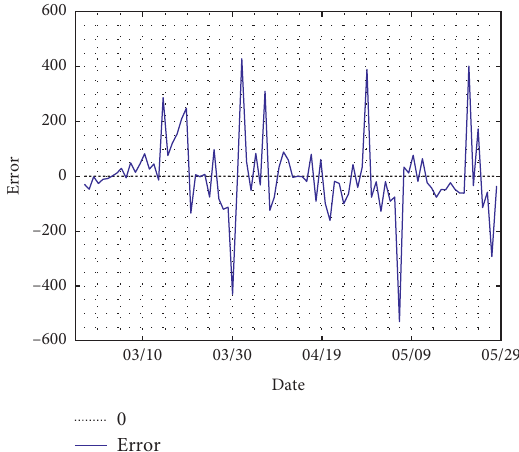
Figure 8: The fitting error of France with a mean absolute error of 96.